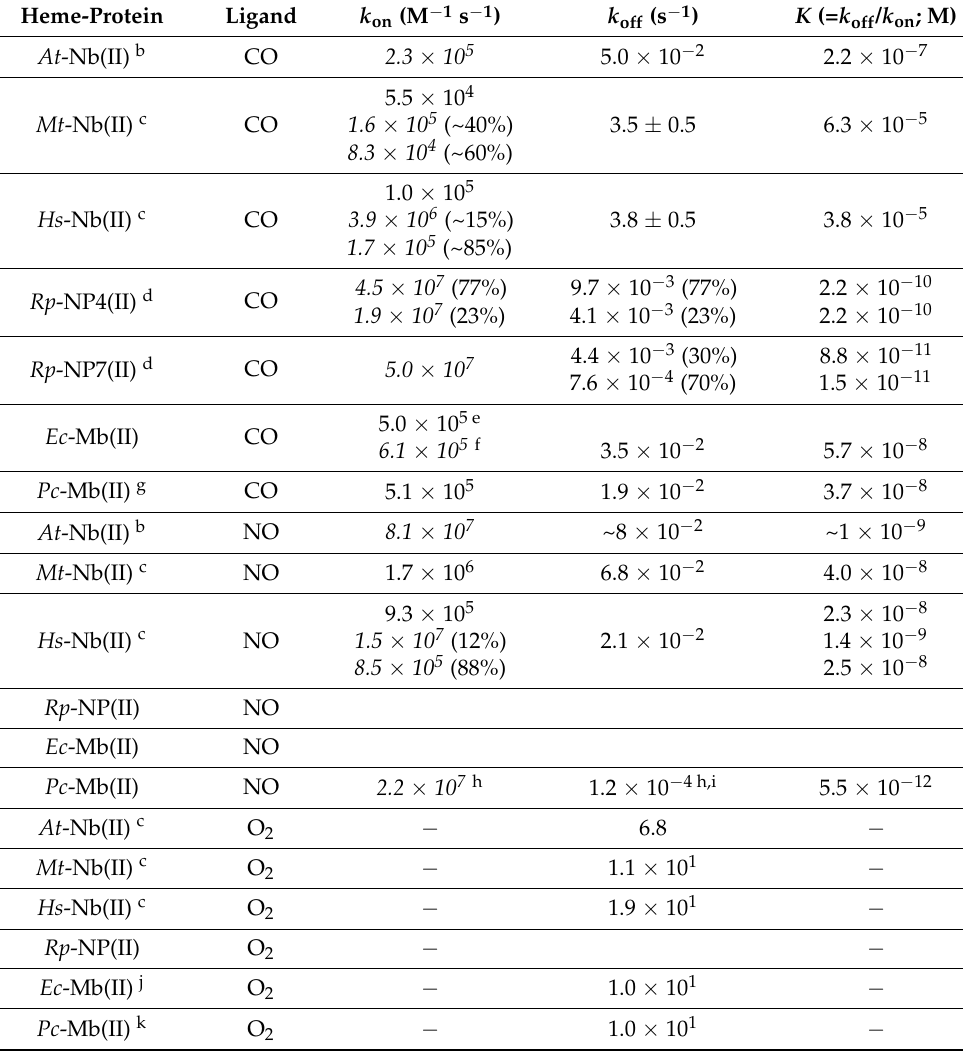
Table 1. Kinetic parameters for CO, NO, and O 2 binding to ferrous heme-proteins a .